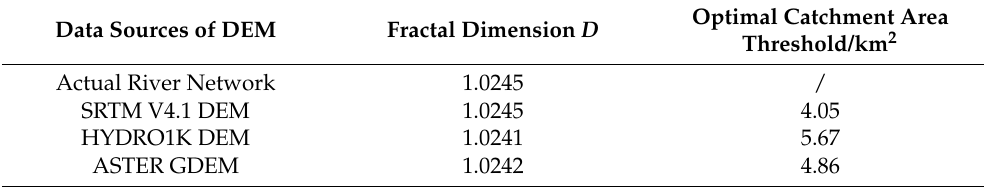
Table 3. Results of optimal catchment area thresholds for the three DEM